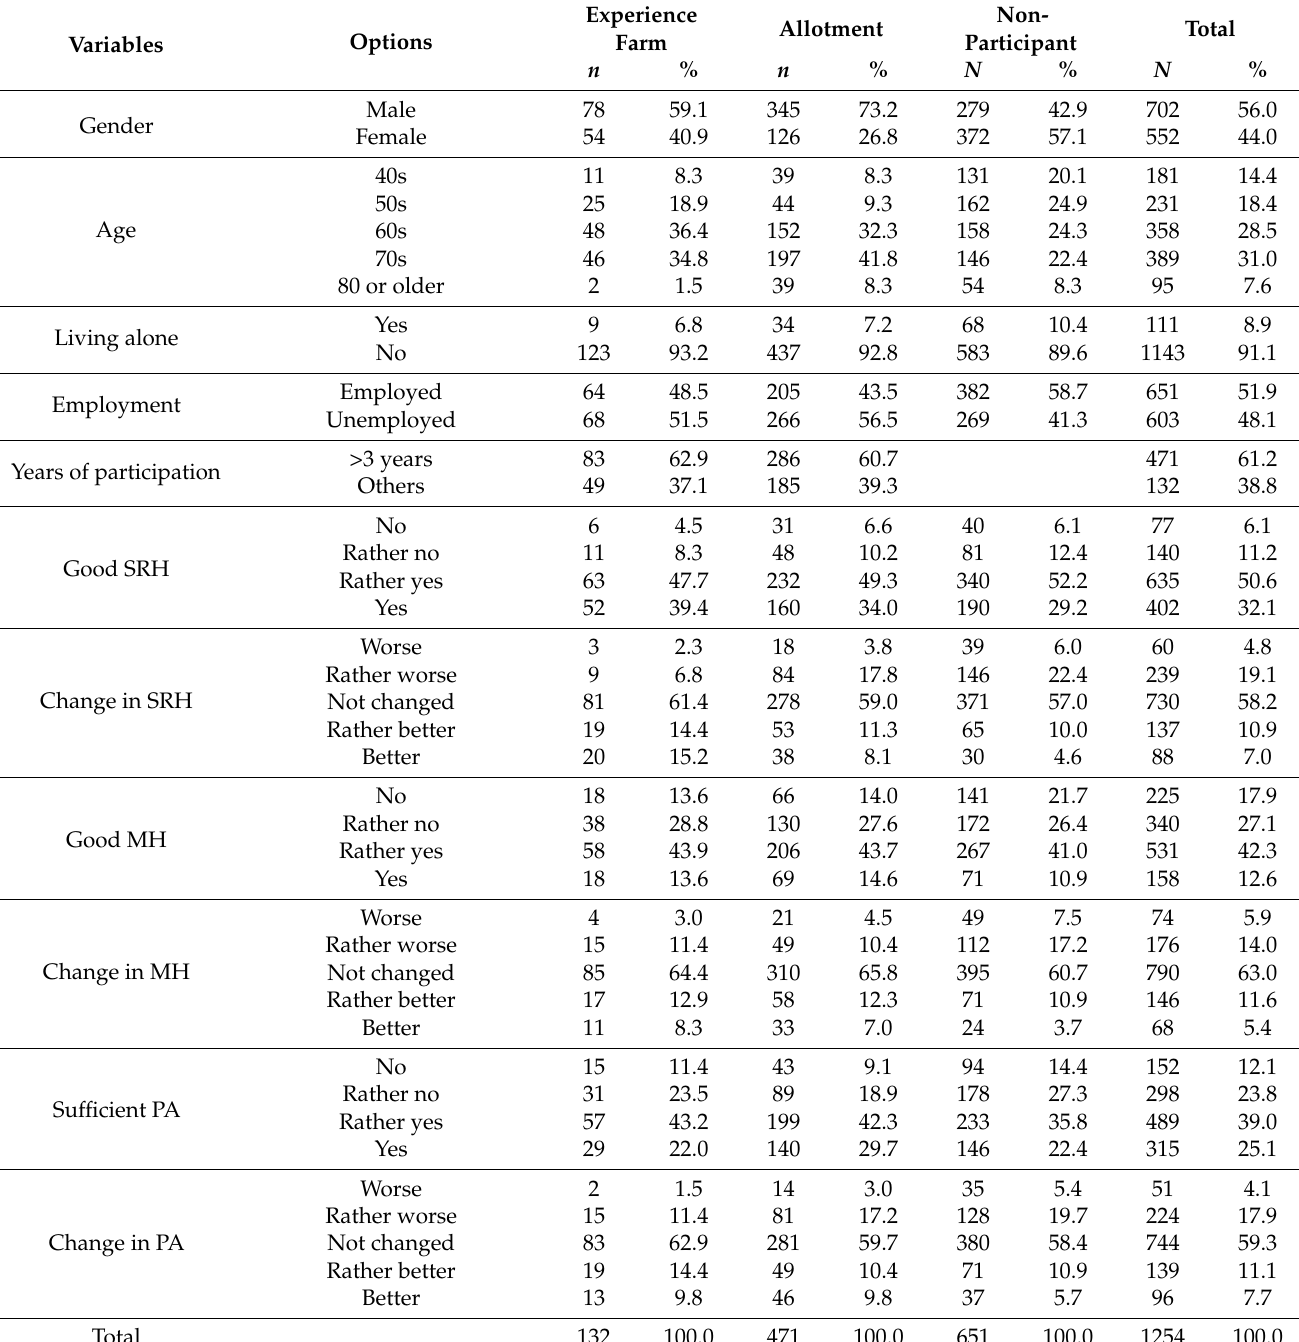
Table 1. Descriptive statistics of respondents ( n =